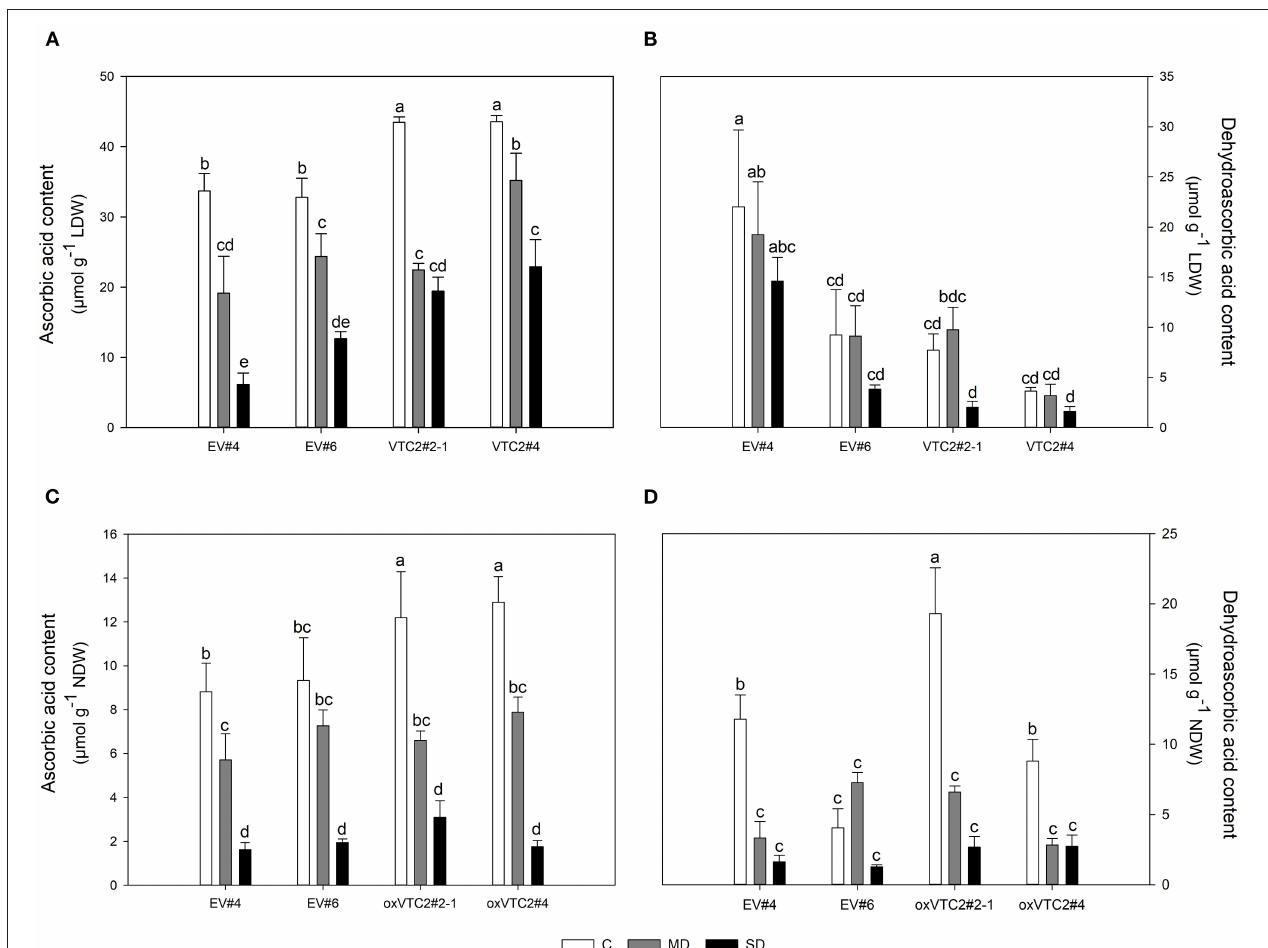
FIGURE 6 | Levels of ascorbic acid (AsA) and dehydroascorbic acid (DHA) in leaves (A,B) and nodules (C,D) of M. truncatula empty vector (EV) and oxVTC2 plants under well-watered control (C), mild drought (MD), and severe drought (SD) conditions. Values represent the average ± SE ( n = 5 biological replicates). Mean values represented by the same letter do not differ statistically ( p ≤ 0.05 ANOVA test). LDW, leaf dry weight; NDW, nodule dry